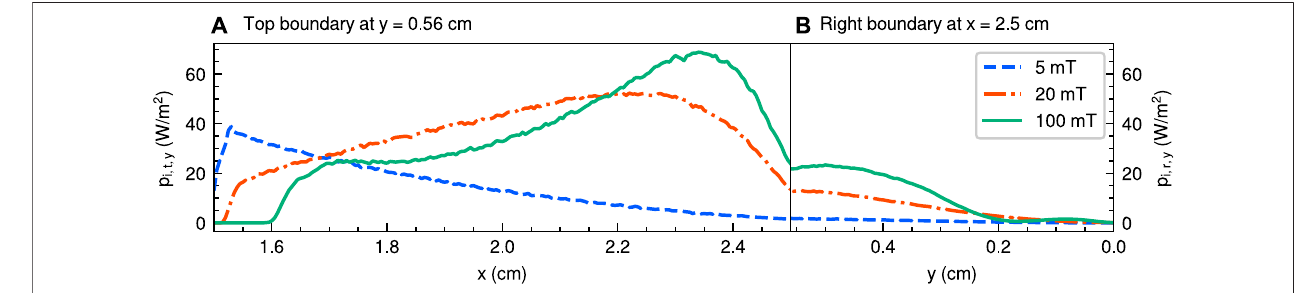
FIGURE 9 | (A) x and (B) y pro fi les of the ion energy fl uxes in the y -direction on the top boundary ( y (cid:1) 0.56 cm) p i , t , y and the right boundary ( x (cid:1) 2.5 cm) p i , r , y , respectively, for the three magnetic fi eld strengths of 5(a dashed blue line), 20(a dotted-dashed orange line), and 100 mT (a solid green line). Note that x (cid:1) 2.5 cmin (A) corresponds to y (cid:1) 0.56 cm in (B) .